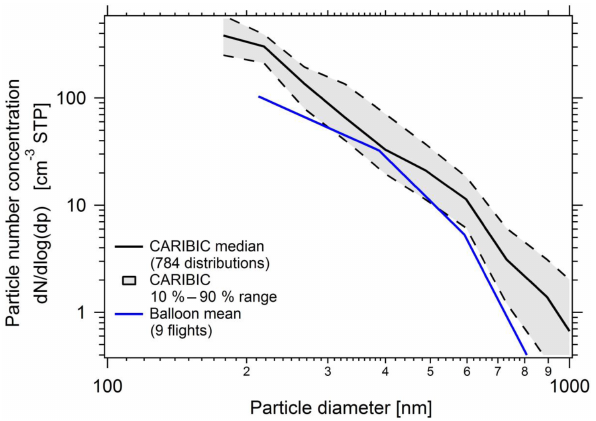
Figure 12. Comparison of particle number size distributions mea- sured with a balloon-borne OPSS (Deshler et al., 2003) and the CARIBIC OPSS. Underlying data were all taken in the midlatitude LMS (south of 65 ◦ N; 150–700ppbv ozone) from periods in 2010– 2013 with little or no volcanic influence on the LMS aerosol (see Andersson et al., 2015, Fig. 1).